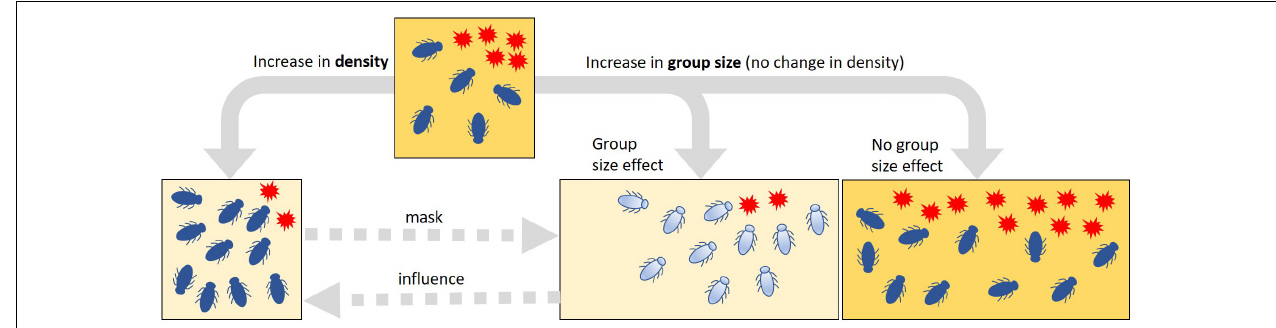
FIGURE 1 | Summative vs. collective effects of variation in the density or group size of insects on the spread of harmful microbes. Increased suppression of harmful microbes (red stars) can be the result of an increase in both density and group size in a habitat (squares). In a pure density effect, this change in suppression occurs only passively through the additive effects of the antimicrobial activity of the individuals; an increase in density (i.e., changes in the number of insects, but no change in habitat size as indicated by the square size) does not change the quality or the intensity of the antimicrobial properties. If there are elements of a collective defense in the control of harmful microbes that is based on an active change in the quality or the intensity of antimicrobial properties (depicted by the change in insect and habitat coloration), it is to be expected that the suppression of microbes is stronger in large than in small groups. If there is no such group size effect, the harmful microbes would spread in proportion to habitat size. To detect such group size effects and thus the potential collective actions, it is important to carefully control the effects of density changes experimentally. Density effects may mask potential group size effects, but group size effects can be part of and possibly amplify density effects (dashed